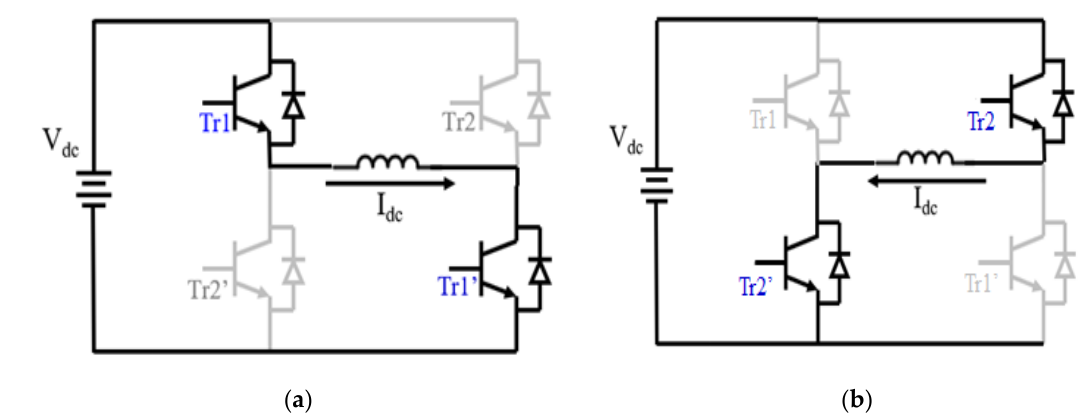
Figure 5. Current flow direction due to switch conduction: ( a ) Step 1: Tr1 and Tr’ conduction; ( b ) Step 2: Tr2 and Tr2’ conduction.